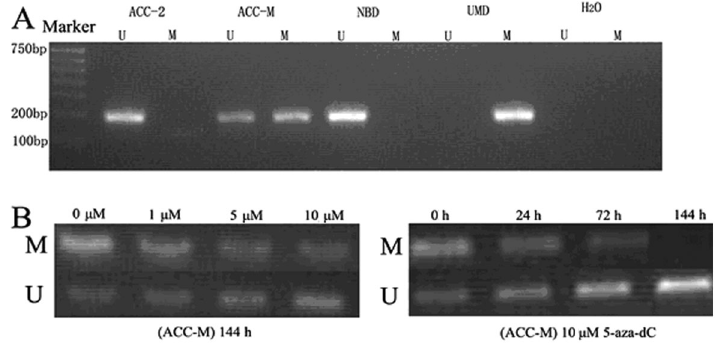
Figure 2. A , Methylation status of the RECK gene in ACC-2 and ACC-M cell lines. M: methylation- specific band; U: unmethylation-specific band; NBD: normal blood DNA as positive control for unmethylated status; UMD: universal methylated DNA as positive control for methylated status; H 2 O: negative control. B , Alterations of methyla- tion status of the RECK gene in ACC-M cell lines after treatment with 1, 5, 10 m M 5-aza-2 9 deox- ycytidine (5-aza-dC) for 144 h and treated for 24, 72, and 144 h with 10 m M